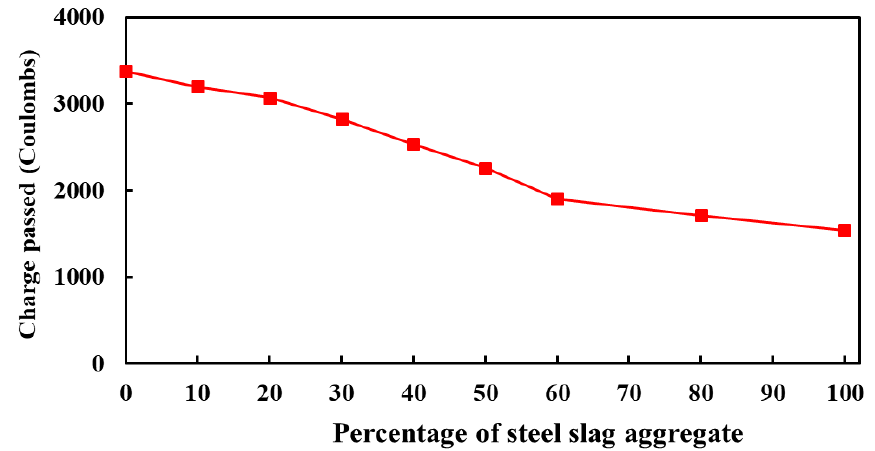
Figure 11. Charge passed into the concrete made with different percentages of IFSSA.